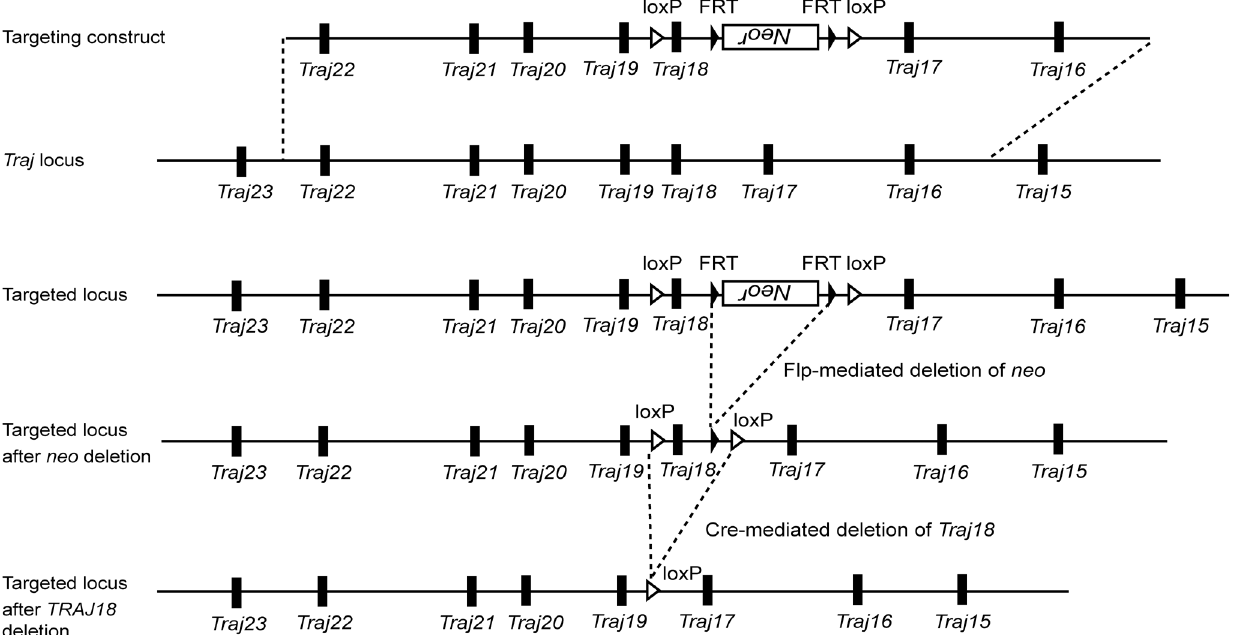
Fig 1. Generation of novel Traj18 -deficient mice. Schematic representation of a Traj18 region targeting construct, Traj18 region before and after homologous recombination, and the genomic locus after FLP- and Cre-mediated deletions of the neomycin resistance gene and Traj18 , respectively.